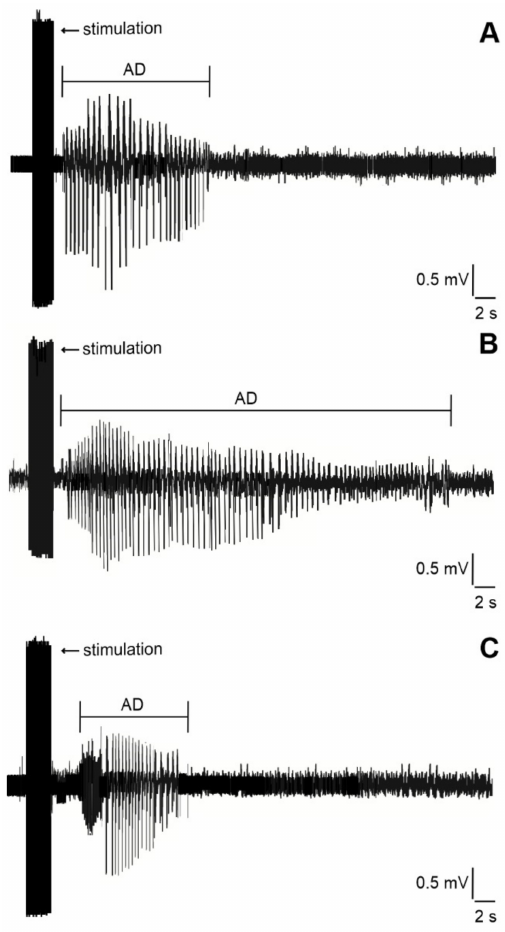
Figure 6. Hippocampal ADs elicited by electrical stimulation in 32-day-old rats accompanied by epileptic automatisms (wet dog shakes). From top to bottom: ( A ) in control animal, ( B ) in LiCl/pilocarpine SE rat, ( C ) in LiCl/pilocarpine SE rats after the administration of 5-ITU at a dose of 3.1 mg/kg (see